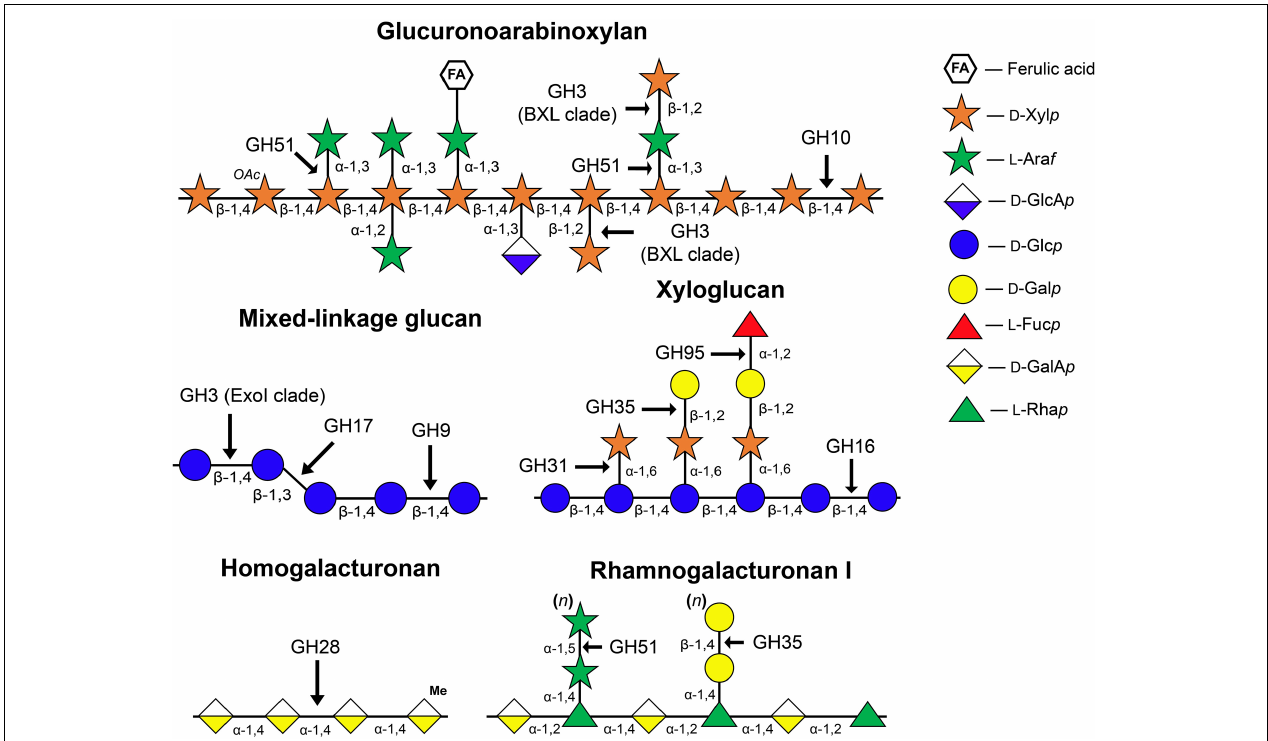
FIGURE 1 | Structure of matrix polysaccharides typical for primary cell walls and enzyme families whose members catalyze the cleavage or modification of glycosidic linkages indicated by arrows. The symbolic representation of monosaccharides is according to GlycoPedia (Pérez, 2014) https://www.glycopedia.eu. GH, glycoside